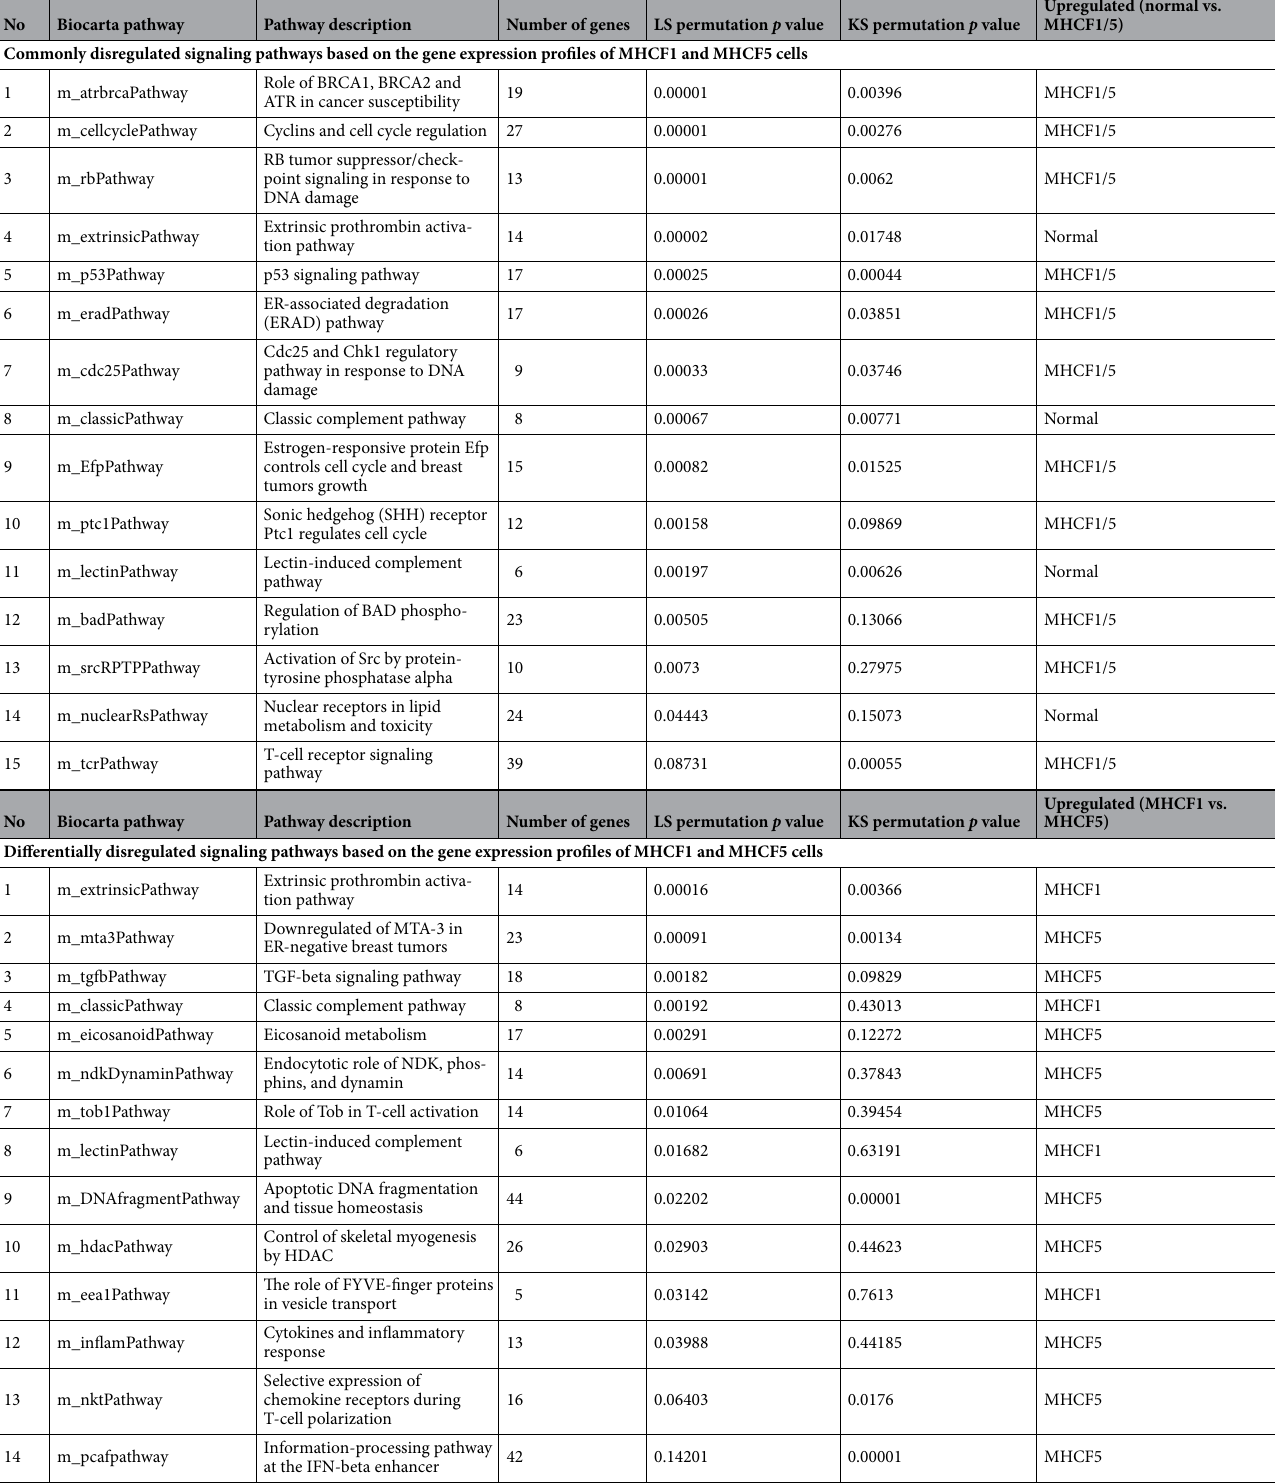
Table 1. Commonly and differentially disregulated signaling pathways based on the gene expression profiles of MHCF1 and MHCF5